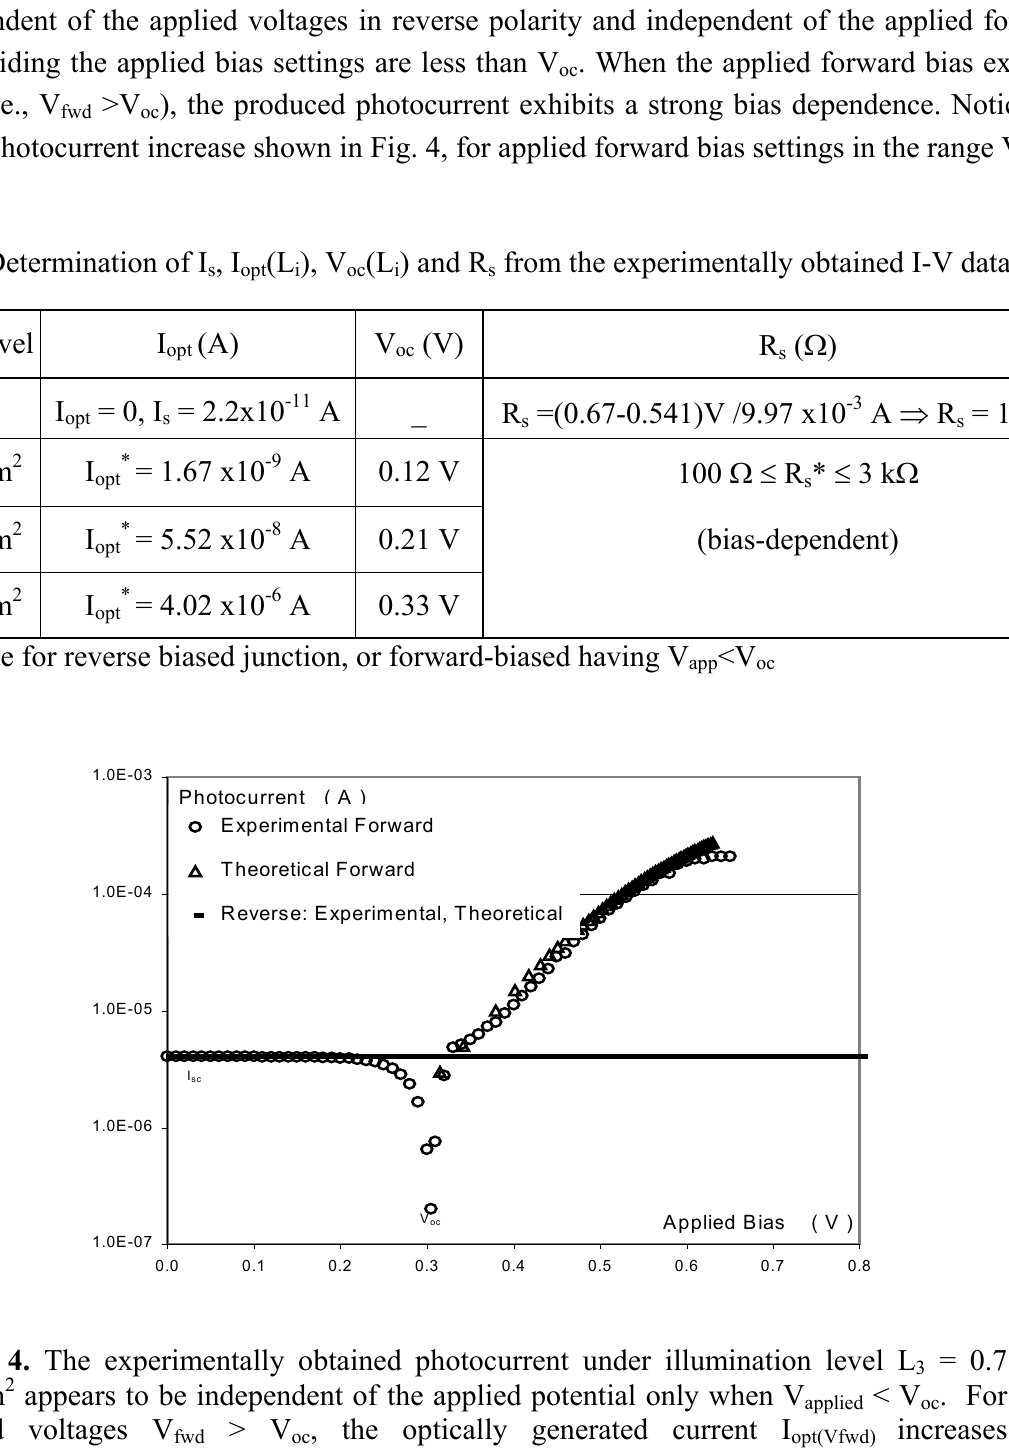
, I (L ), V (L ) and R from the experimentally obtained I-V data. s opt i oc i s